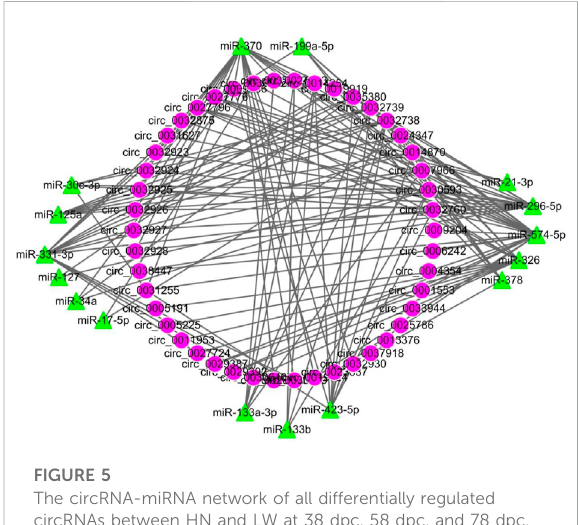
FIGURE 5 The circRNA-miRNA network of all differentially regulated circRNAs between HN and LW at 38 dpc, 58 dpc, and 78 dpc. Circular nodes represent circRNAs; triangular nodes represent